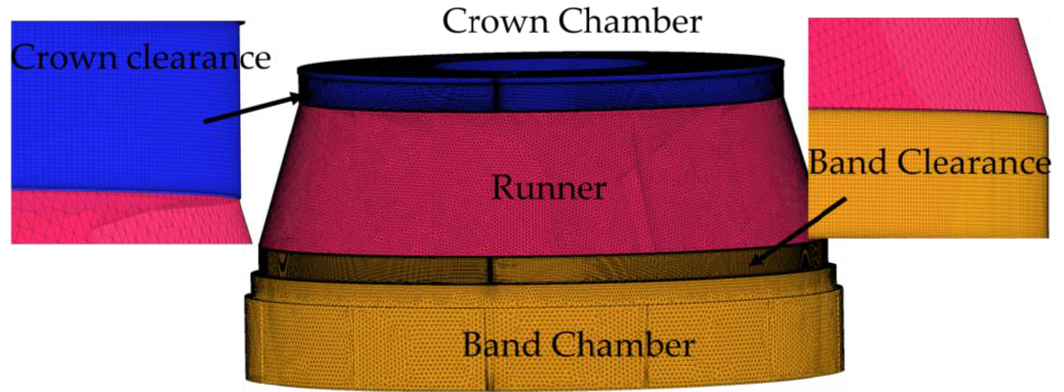
Figure 2. Clearance grids.